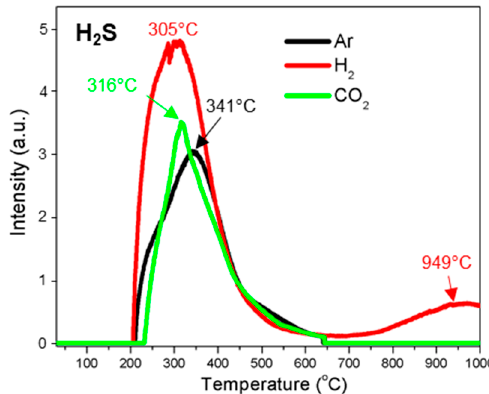
Figure 5. H 2 S evolution profiles of the thermal decomposition of kraft lignin under argon (Ar), hydrogen (H 2 ), and carbon dioxide (CO 2 ) atmospheres. Table 1. Summary of gas/volatile evolution temperature ranges and peak temperatures of thermal decomposition of kraft lignin under different atmospheres.